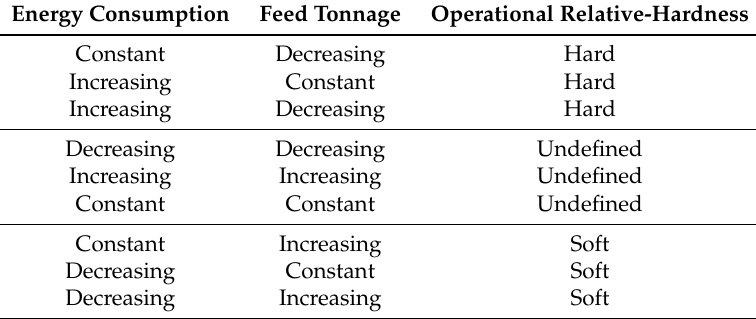
Table 1. Operational relative-hardness criteria based on one time-step difference of energy consumption and feed tonnage. Energy Consumption Feed Tonnage Operational Relative-Hardness Constant Decreasing Hard Increasing Constant Hard Increasing Decreasing Hard Decreasing Decreasing Undefined Increasing Increasing Undefined Constant Constant Undefined Constant Increasing Soft Decreasing Constant Soft Decreasing Increasing